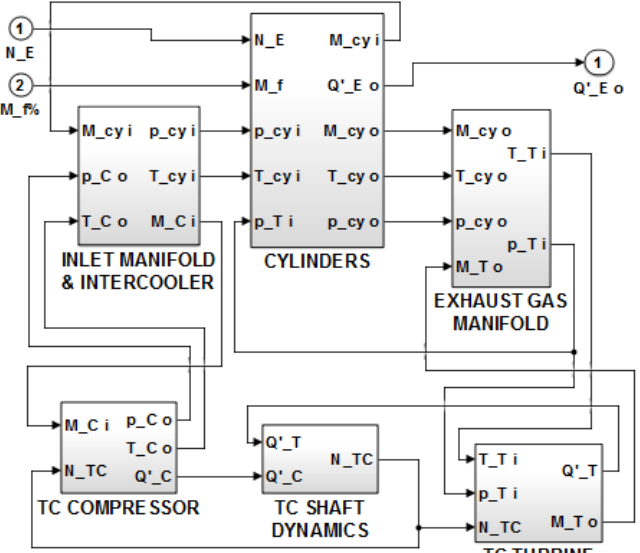
Figure 1. Simulink engine model, where M_f = fuel rate; M_C i = compressor inlet air mass flow; M_cy i = cylinders inlet air mass flow; M_cy o = cylinders gas mass flow; M_T o = turbine outlet gas mass flow; N_E = engine speed; N_TC = turbocharger shaft speed; p_C o = compressor outlet pressure; p_cy i = cylinder inlet pressure; p_cy o = cylinder outlet pressure; p_T i = exhaust gas manifold outlet pressure; Q’_C = compressor torque; Q’_E o = engine delivered torque; Q’_T = turbine torque; T_C o = compressor outlet temperature; T_cy i = cylinder inlet temperature; T_cy o = cylinder outlet temperature; T_T i = turbine inlet temperature.